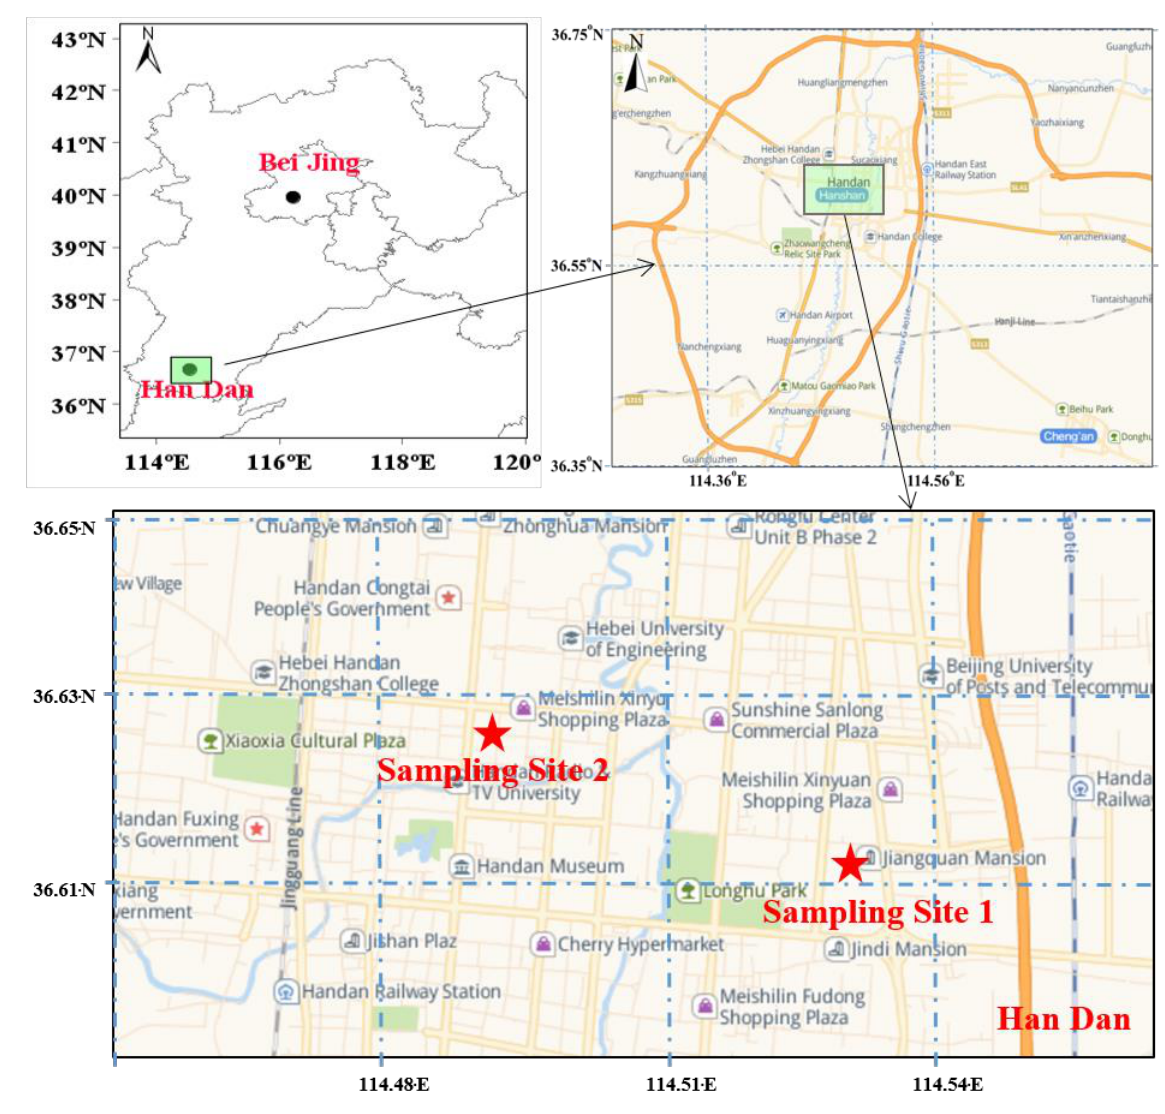
Figure 1. Schematic diagram of sampling locations.